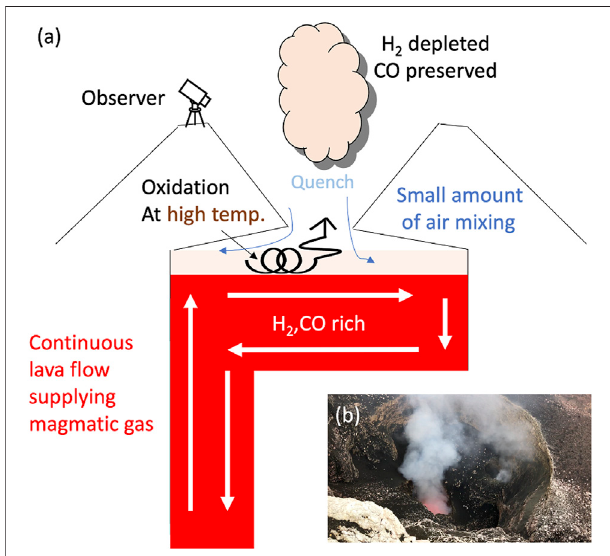
FIGURE9| SchematicdiagramtoshowtheoxidizationofH 2 intheairat Masaya Volcano. (A) Cartoon to show the lava lake and the oxidization of the volcanic gases. Initially, when the volcanic gases are in equilibrium with the surrounding magma (red fi lled area; white arrows show the lava fl ow direction inferred from Pering et al. (2019)), the gases are rich in H 2 and CO. Mixingwiththeair(bluearrows)atahightemperature oxidizesH 2 (transparent orange area with coil-shaped arrows), then, the volcanic gases are quenched at the outlet of the vent, resulting in a poor H 2 composition as observed. In contrast,COispreservedbecauseCOislikelytobekineticallyinertcompared to H 2 (Roberts et al., 2019). (B) Photo taken at the rim of the Santiago crater, Masaya Volcano, Nicaragua. Observers could see only a portion of the lava lake through the window (i.e., the outlet of the